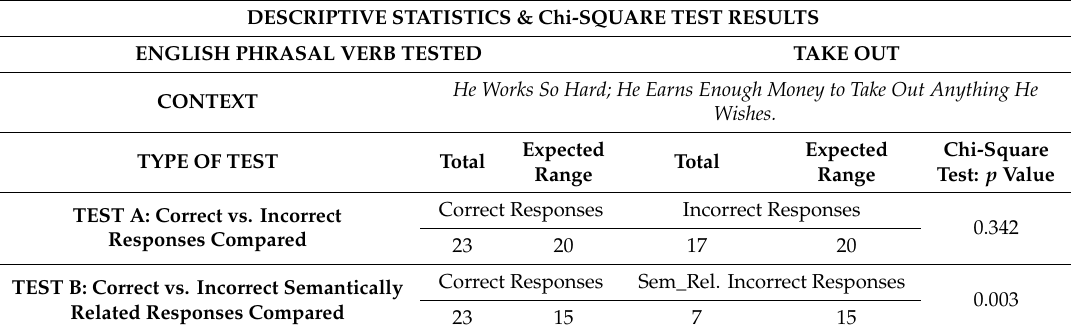
Table 7. Chi-square tests for take out